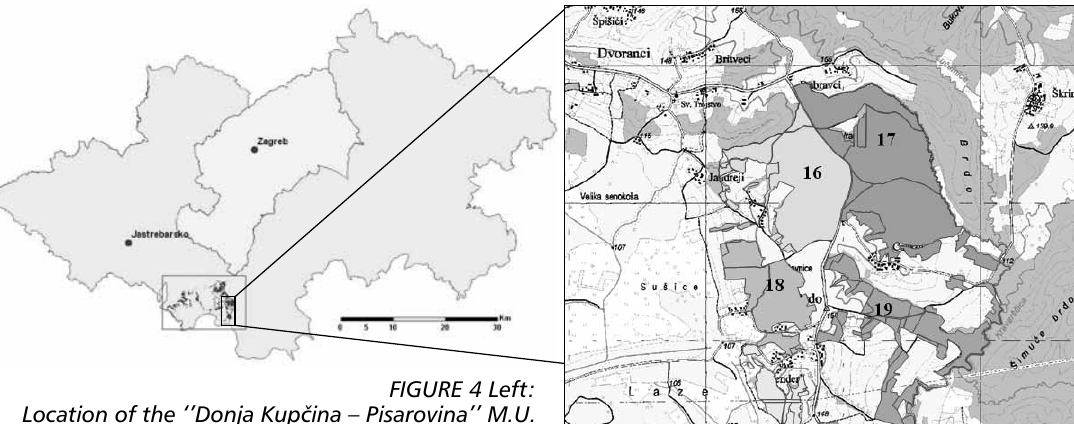
FIGURE 4 Left: Location of the ‘’Donja Kupčina – Pisarovina’’ M.U. in Zagreb County. Right: Selected research area (compartments 16 to